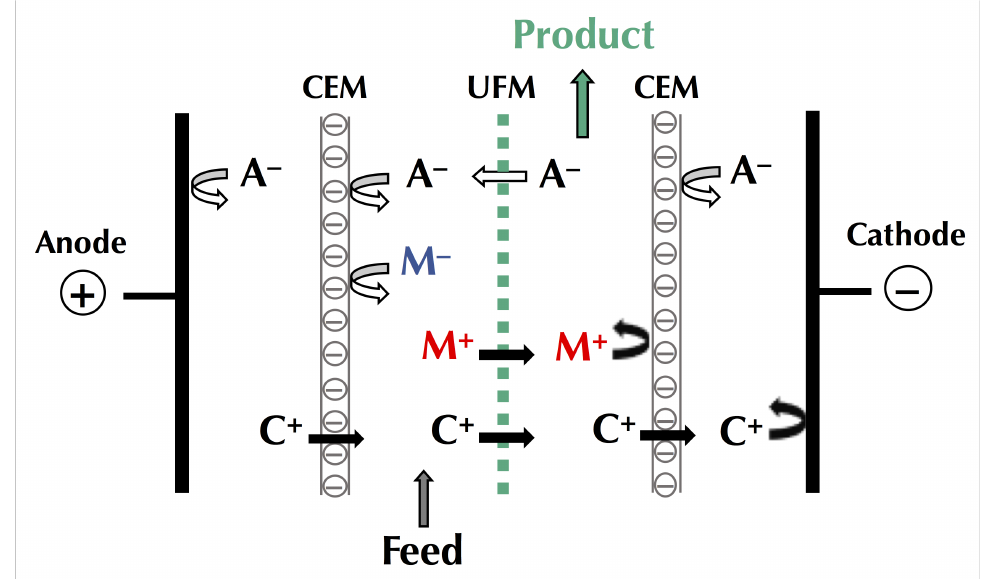
Figure 22. Principle of EDFM using a cationic configuration. CEM: cation-exchange membrane; FM: filtration membrane, A − : anions; C + : cations; M − , M + : charged